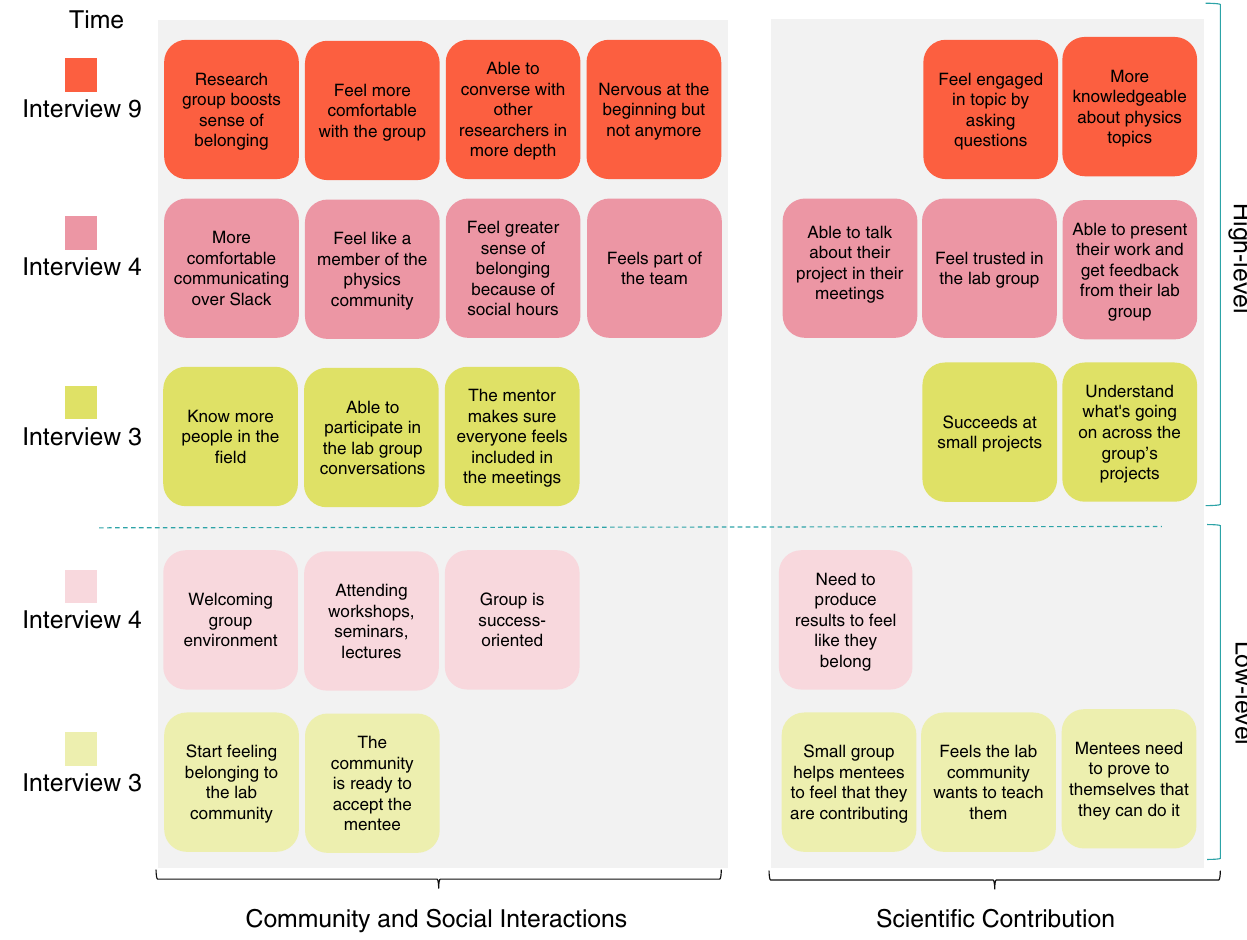
FIG. 2. Process of growth in mentees ’ sense of belonging as a function of time. The areas shaded in a lighter color denote the lower- level of SOB while the areas shaded in a darker color denote the higher level of SOB. The text in the boxes are paraphrases of mentees ’